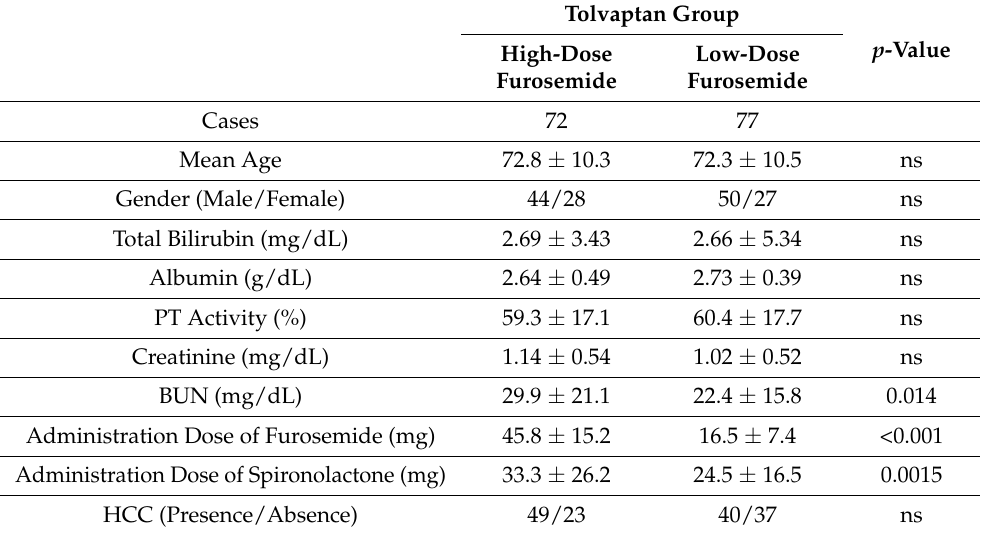
Table 4. Clinical backgrounds in the two tolvaptan groups. The tolvaptan group was divided into two groups according to the dose of furosemide administered on admission (<40 mg/day, low-dose furosemide group; ≥ 40 mg/day, high-dose furosemide group).